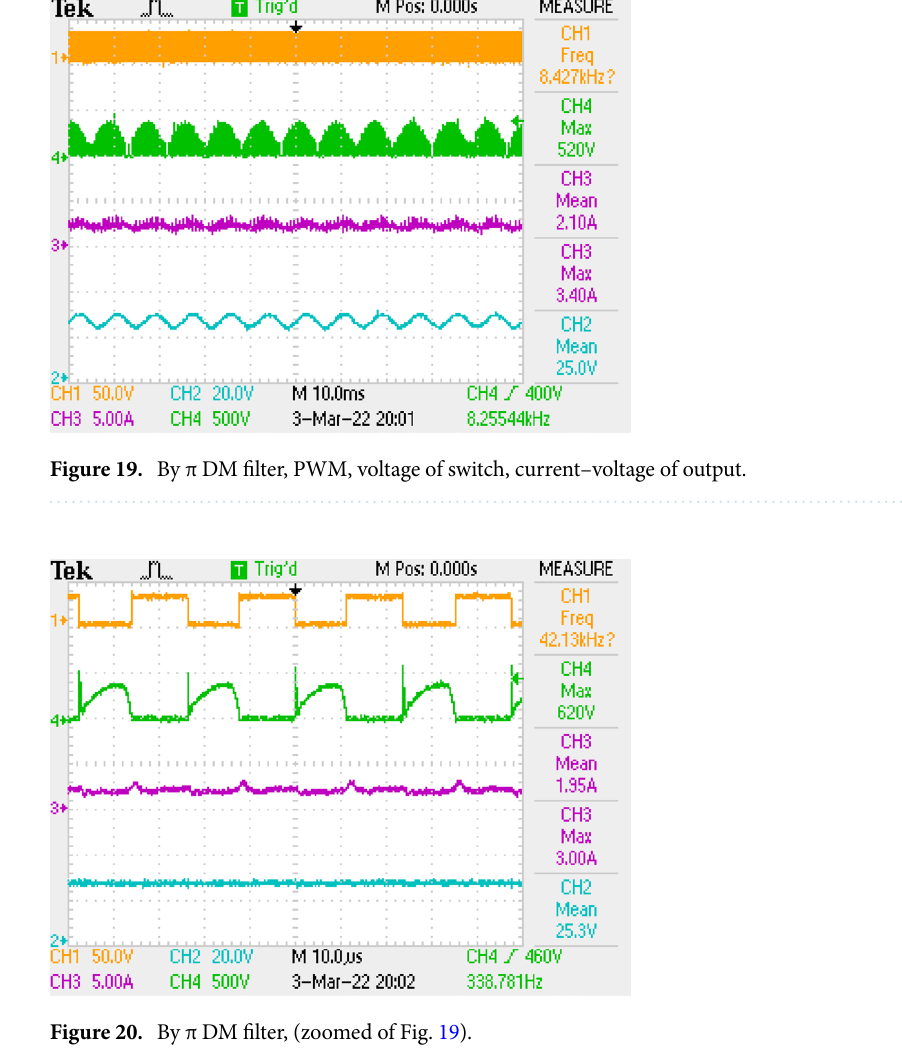
Figure 20. By π DM filter, (zoomed of Fig. 19).